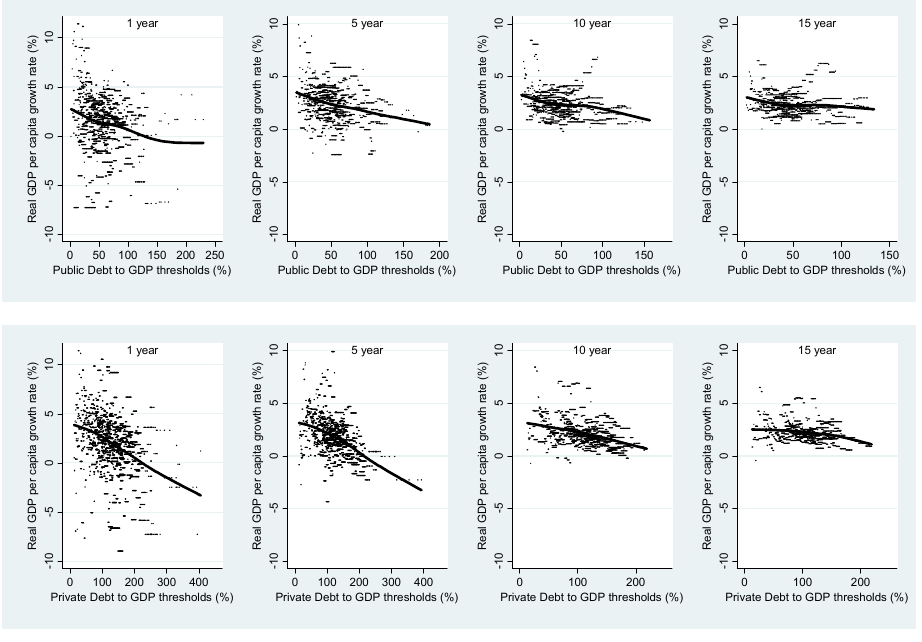
Figure 6 - Public debt & private debt levels and medium- to long-term economic